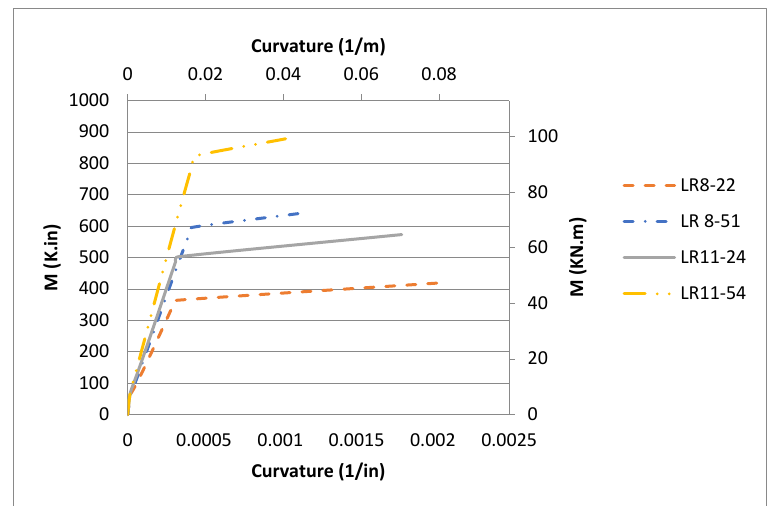
Figure 12. Ahmad and Barker (1991) [16] load vs. midspan deflection comparisons, LR 11 beams.